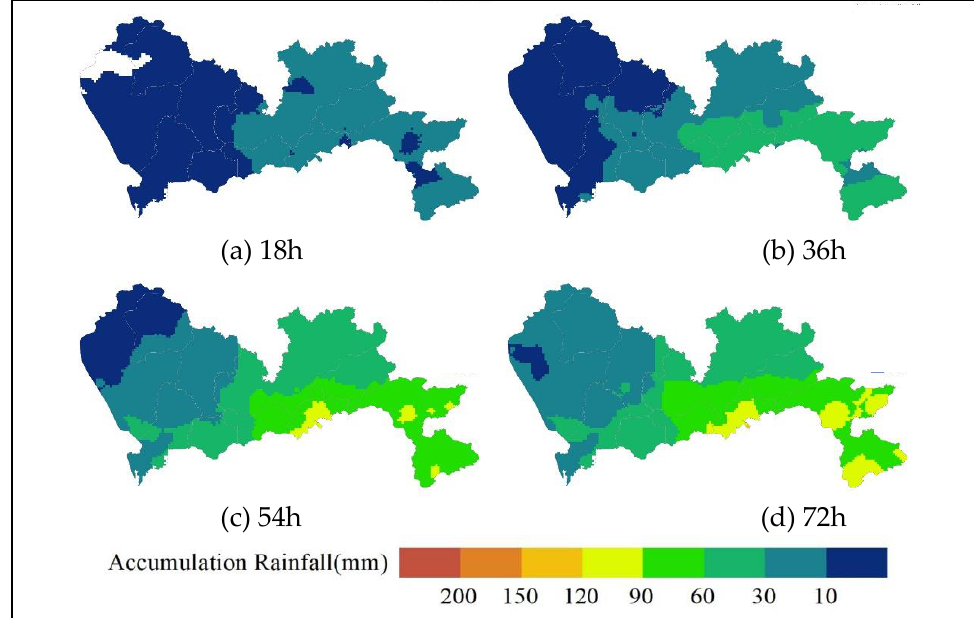
Figure 11. Rainfall accumulation of rainstorm of type III occurred on 12 June 2017.